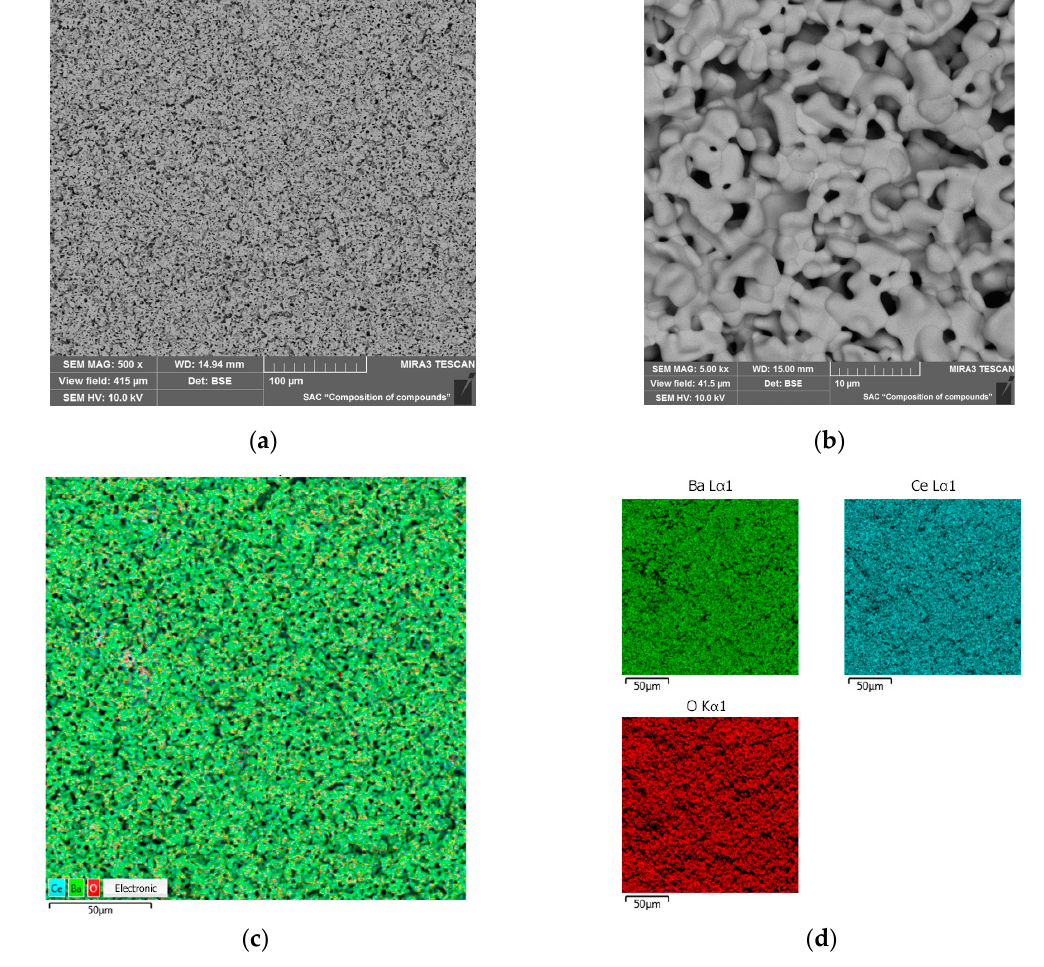
Figure 4. Scanning electron microscope (SEM) images of the surface of the two-layer BCGCuO / BCO film after the final sintering at 1450 ° С , 2 h at different magnifications: ( a ) 500×; ( b ) 5000× and X-Ray energy-dispersive (EDX) mapping image: ( c ) integrated; ( d ) individual elements.